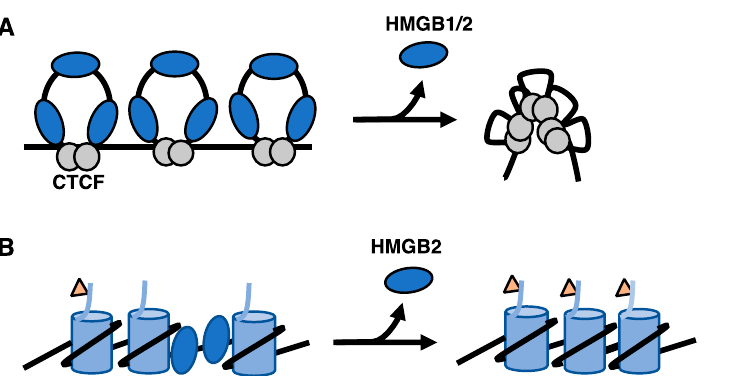
Figure 2. ( A ) HMGB1/2 serves to insulate the interactions between CTCF proteins and demarcate the boundaries of TADs. Loss of HMGB1/2 upon entry into senescence causes clustering of CTCF proteins. ( B ) Loss of HMGB2 during oncogene induced senescence promotes the spread of heterochromatic marks (triangles) into SASP gene loci.